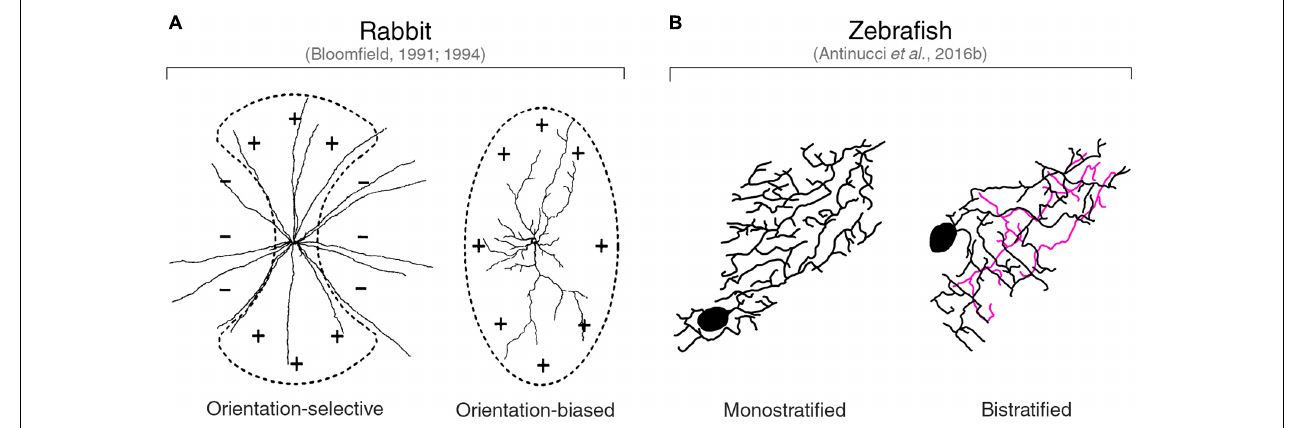
FIGURE 4 | Orientation-tuned amacrine cells in rabbit and zebrafish. (A) Planar dendritic morphology of the two classes of orientation-tuned amacrine cells found in the rabbit retina by Bloomfield (1991, 1994). ‘Orientation-selective’ amacrine cells have a circular dendritic field (left). ‘Orientation-biased’ amacrine cells are characterized by a highly elongated dendritic field (right). Schematic representations of the corresponding receptive fields are overlaid on top of the dendritic arbors. ‘+’ and ‘–’ symbols indicate excitatory and inhibitory inputs, respectively. Images taken from Bloomfield (1994) with permission. (B) Planar dendritic morphology of the two types of orientation-tuned amacrine cells found in the larval zebrafish retina by Antinucci et al. (2016b). Note the high degree of dendritic elongation similar to that observed in rabbit ‘orientation-biased’ amacrine cells. The color coding of neurites indicates the different IPL laminae they are located. Black and magenta lines indicate neurites in OFF and ON laminae, respectively. Images taken from Antinucci et al. (2016b) with